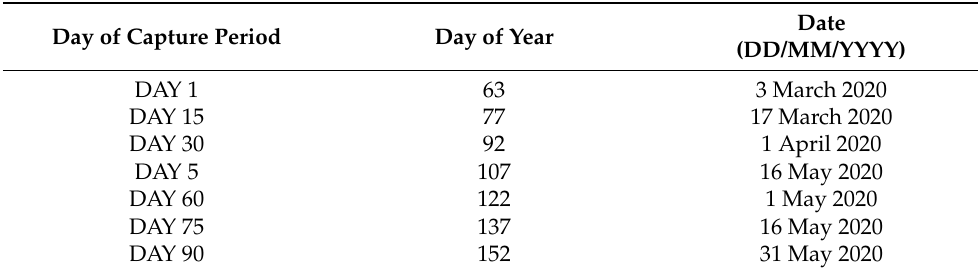
Table 2. Days on which a sample of images were annotated for each AOI with the aim of representing the vegetation at various growth